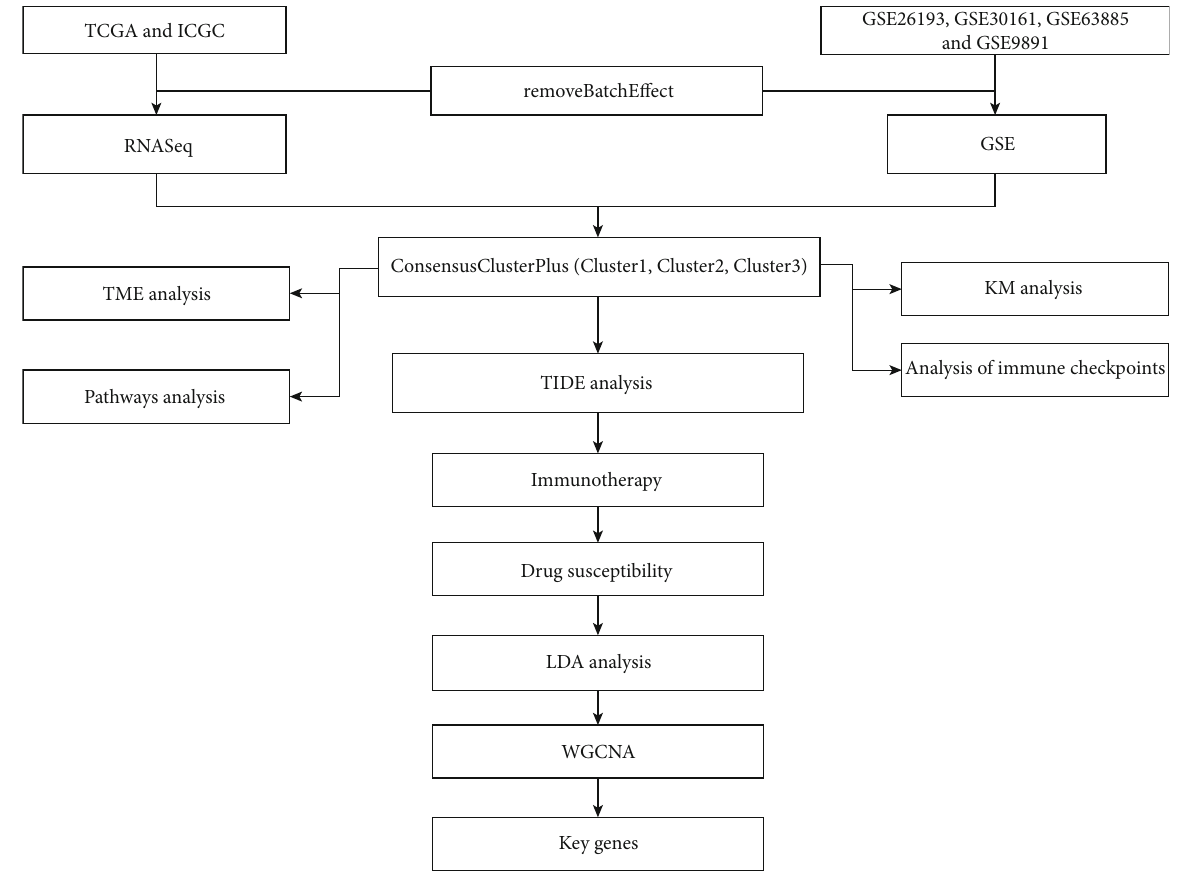
Figure 1: The fl ow chart of this